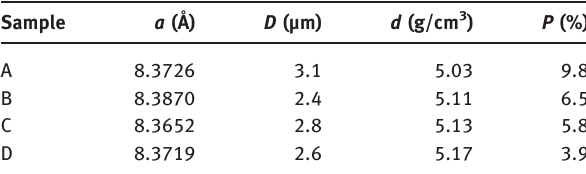
Table 2: Date on lattice parameter ( a ), grain size ( D ), bulk density ( d ), and porosity ( P ) for samples.